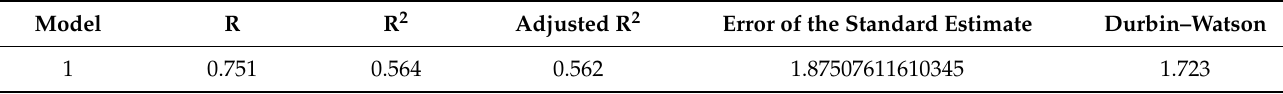
Table 5. Model summary.